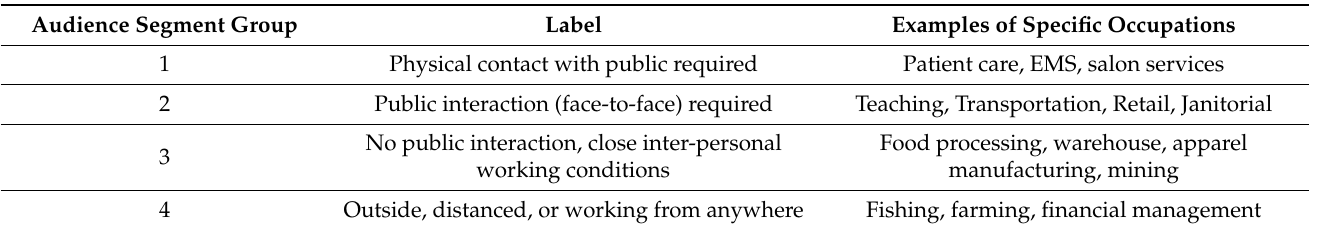
Table 2. Potential Audience Segmentation Based on Perceived Risk of COVID-19 Exposure and